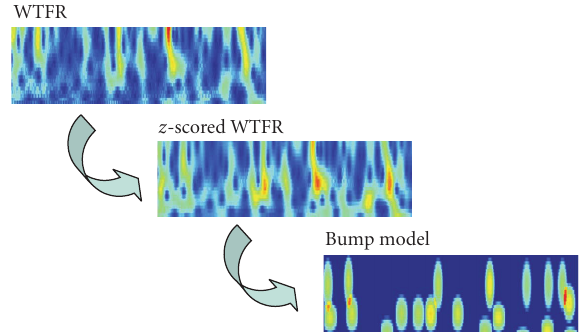
Figure 4: from wavelet time-frequency representation (WTFR) to a sparse time-frequency bump